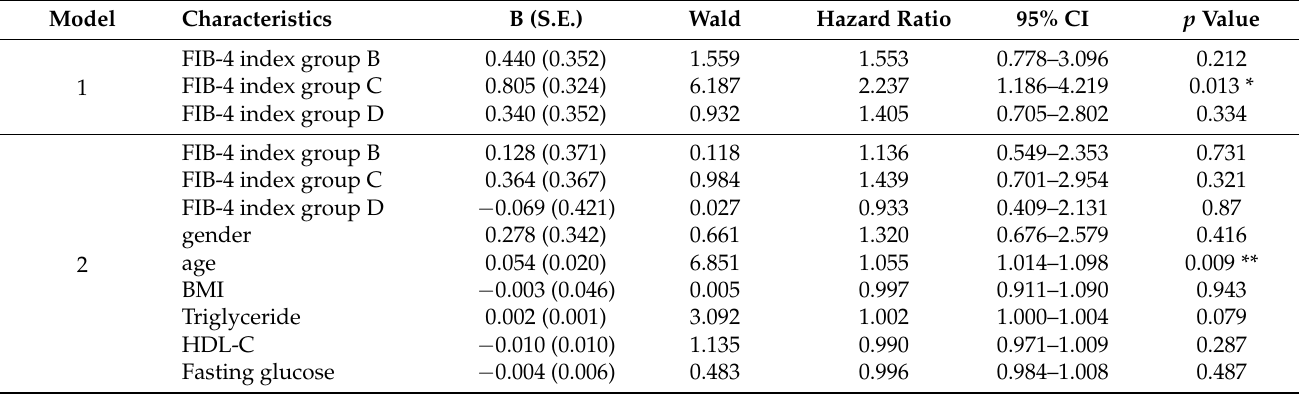
Table 4. Multivariable analysis of the hazard ratios for CKD stage 3–5 in Study 2.